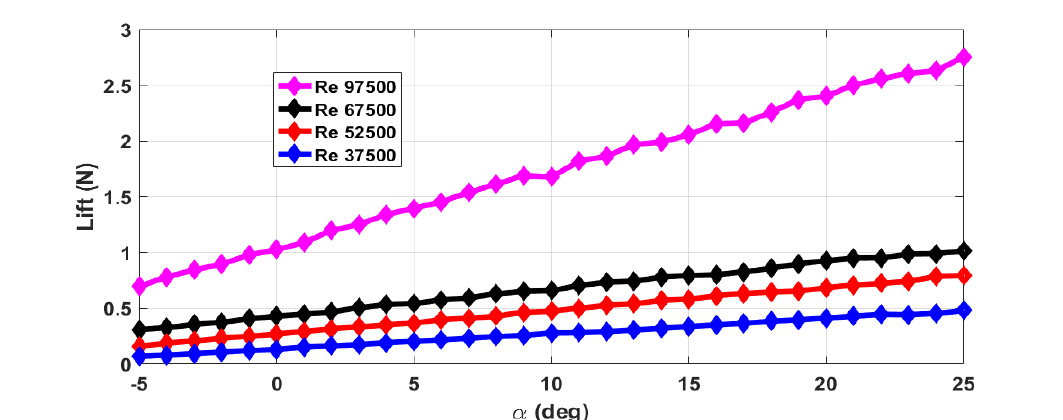
Figure 6. Lift force for + 15 ◦ elevator deflection and zero propeller